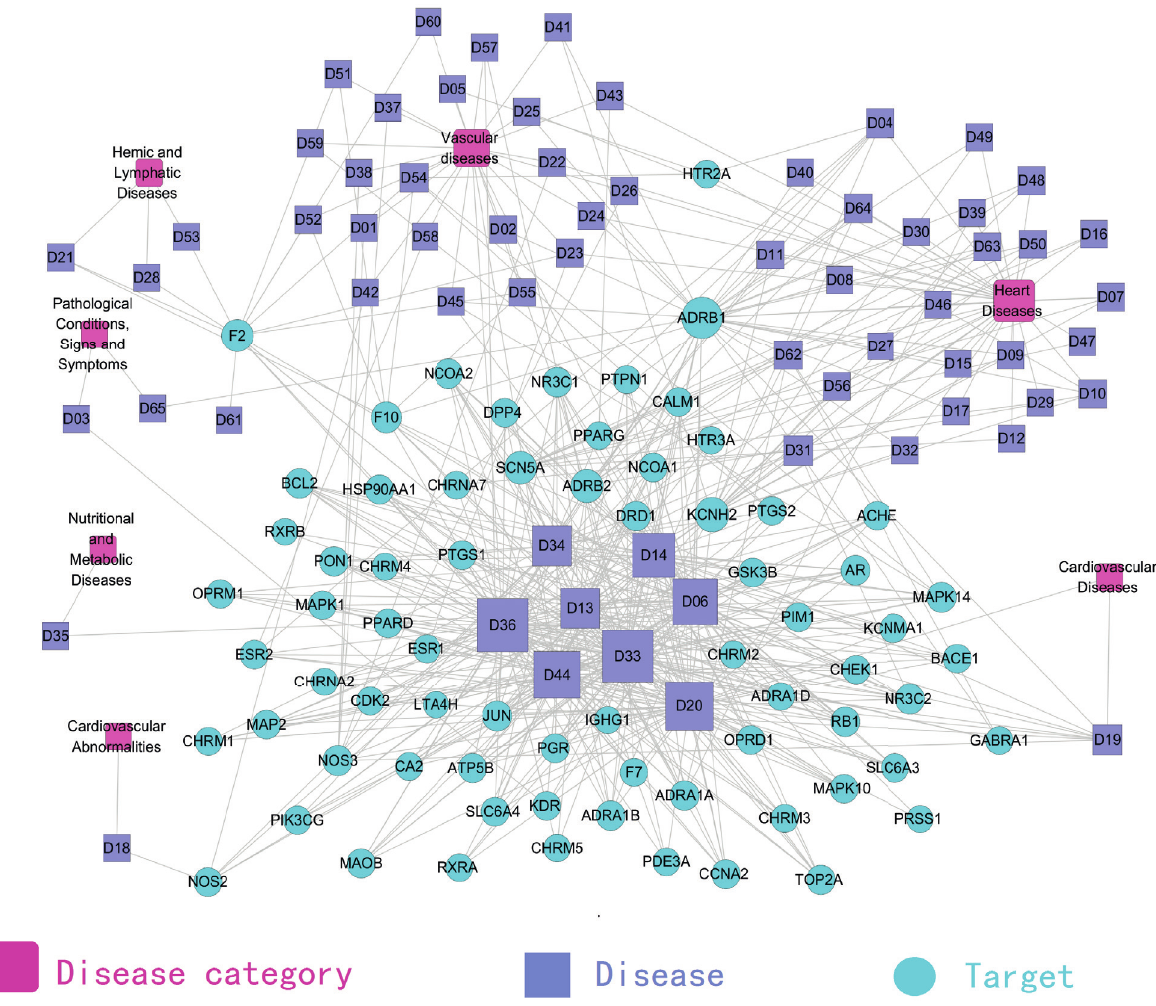
Figure 4 - Target-CVDs associated disease network. Target proteins are linked with their corresponding diseases and those diseases are linked with the corresponding disease categories they belong to. The letters are node